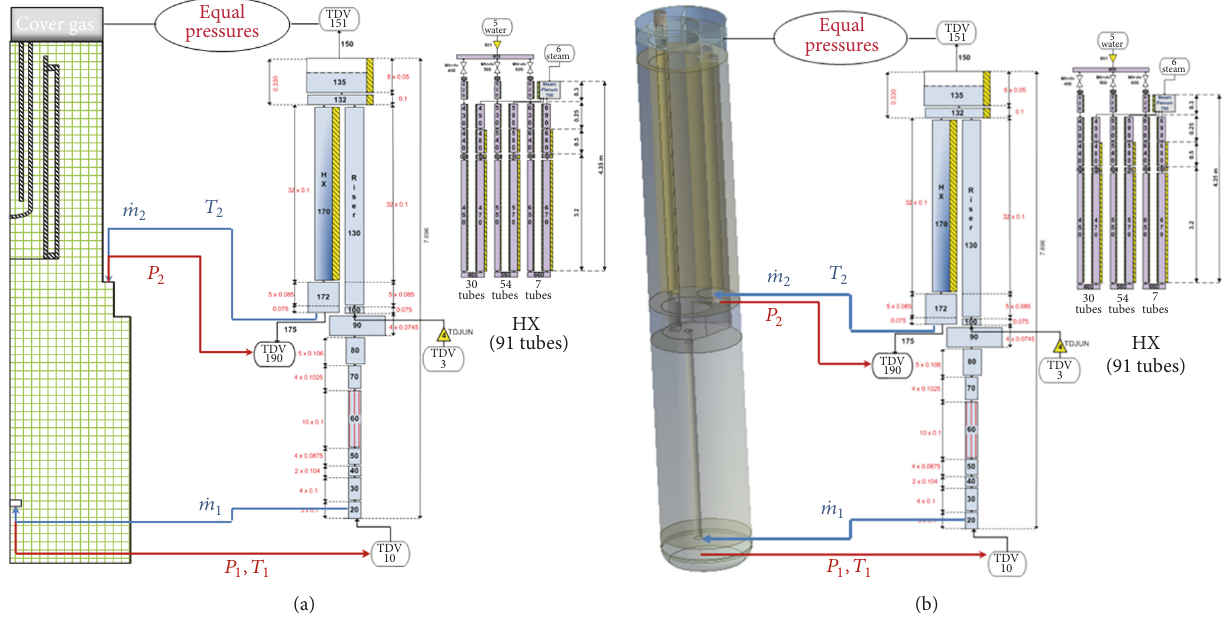
Figure 11: CIRCE-ICE computational domain for coupled calculations, with 2D (a) and 3D (b) CFD models.